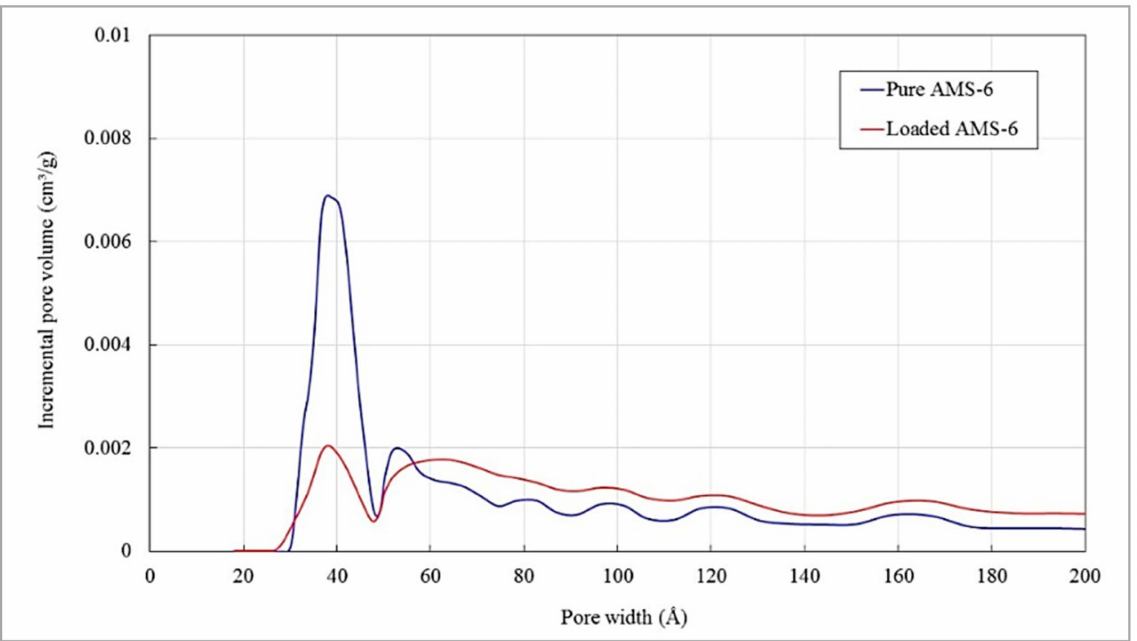
Figure A17. DFT pore size analysis. The pore width of pure AMS-6 and loaded AMS-6-Dox nanoparticles is in the range of 30–50